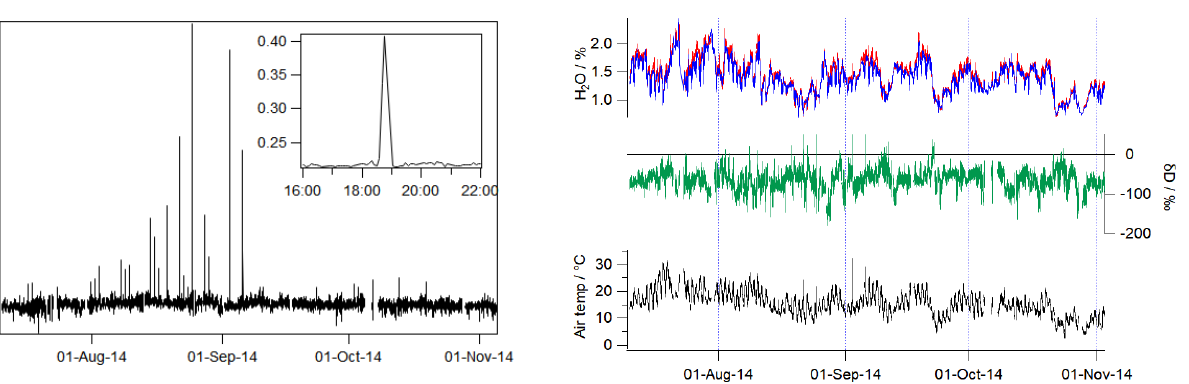
Figure 8. Water vapour, δ D and air temperature for the whole mea- surement period. In the upper panel the FTIR retrieved water vapour is in red and the IUP meteorological station absolute humidity in blue (as mole fractions in